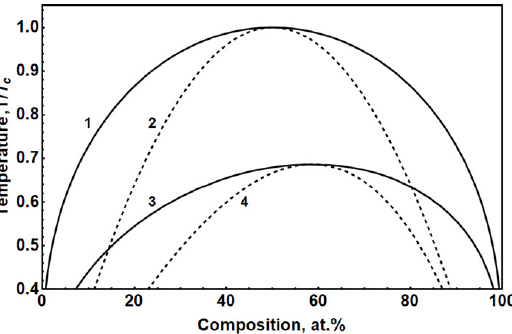
Figure 1. Phase diagram for binary solution (1, 2) and binary solution with respect to electronic subsystem in approximation of ambipolar diffusion (3, 4). Curves 1 and 3 show the temperature dependence of equilibrium composition. The dashed lines 2 and 4 show the metastability